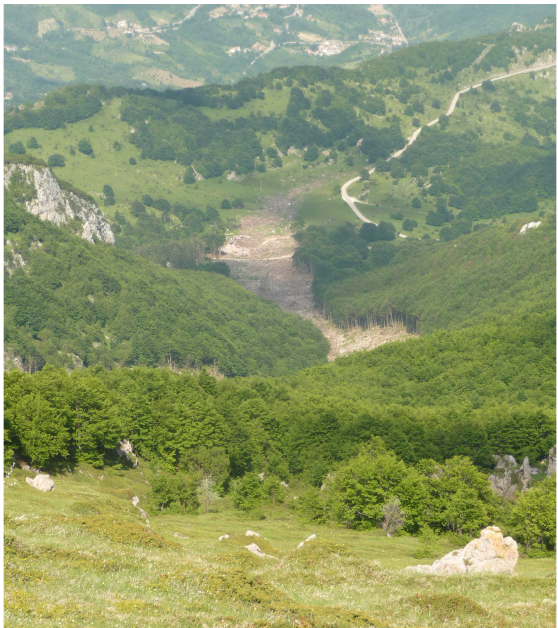
Figure 2. View of the lower part of the Grava dei Bruciati gully and the run-out zone of the avalanche from a point south of the release area at approximately 1700m a.s.l.